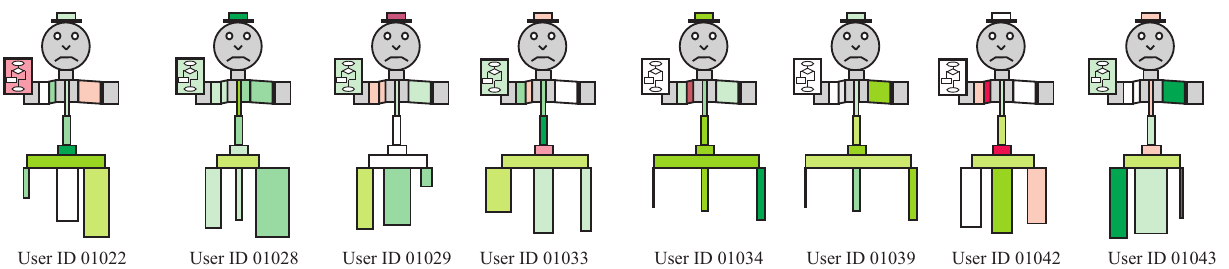
Figure 10. Overlaying data from assignments, tests, and exams on the individualized image in the UGVA notation for the learning group of eight students (group